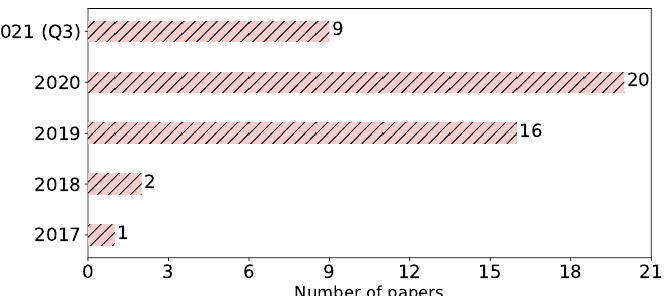
Figure 4. Number of papers per